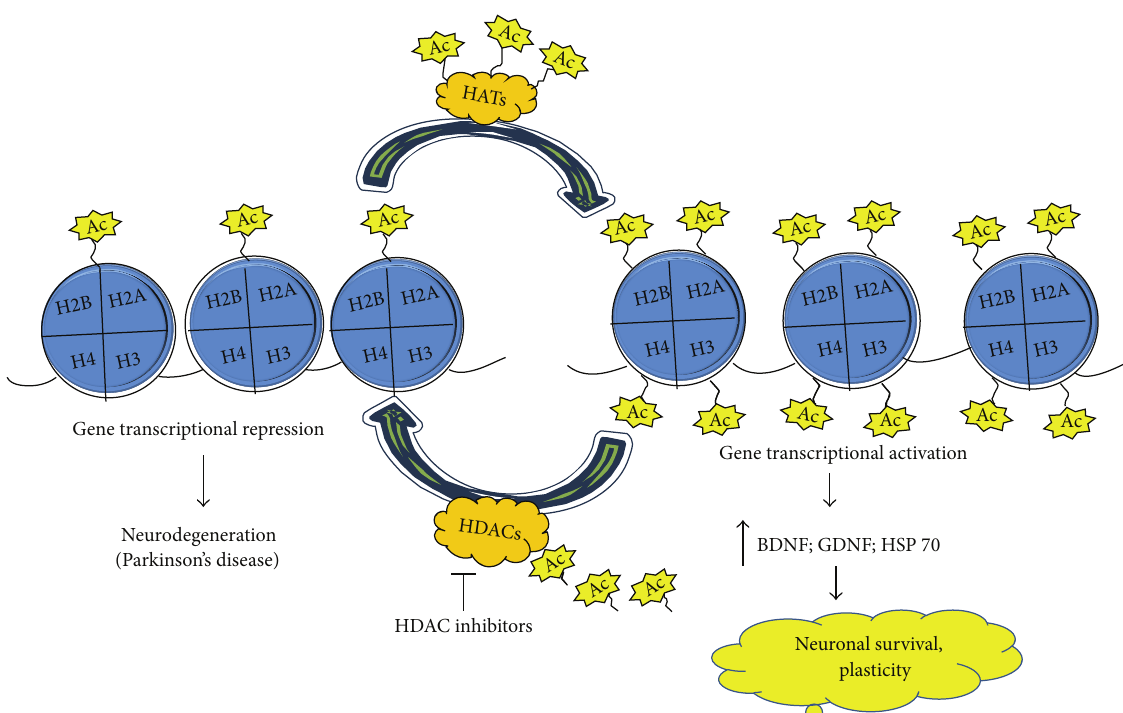
Figure 1: Transcriptional regulation by histone acetyltransferase and histone deacetylases. HAT: histone acetyltransferase, HDAC: histone deacetylases; HSP 70: heat shock protein 70, BDNF: brain derived neurotropic factor, GDNF: glial cell derived neurotropic factor, and PD: Parkinson’s disease.